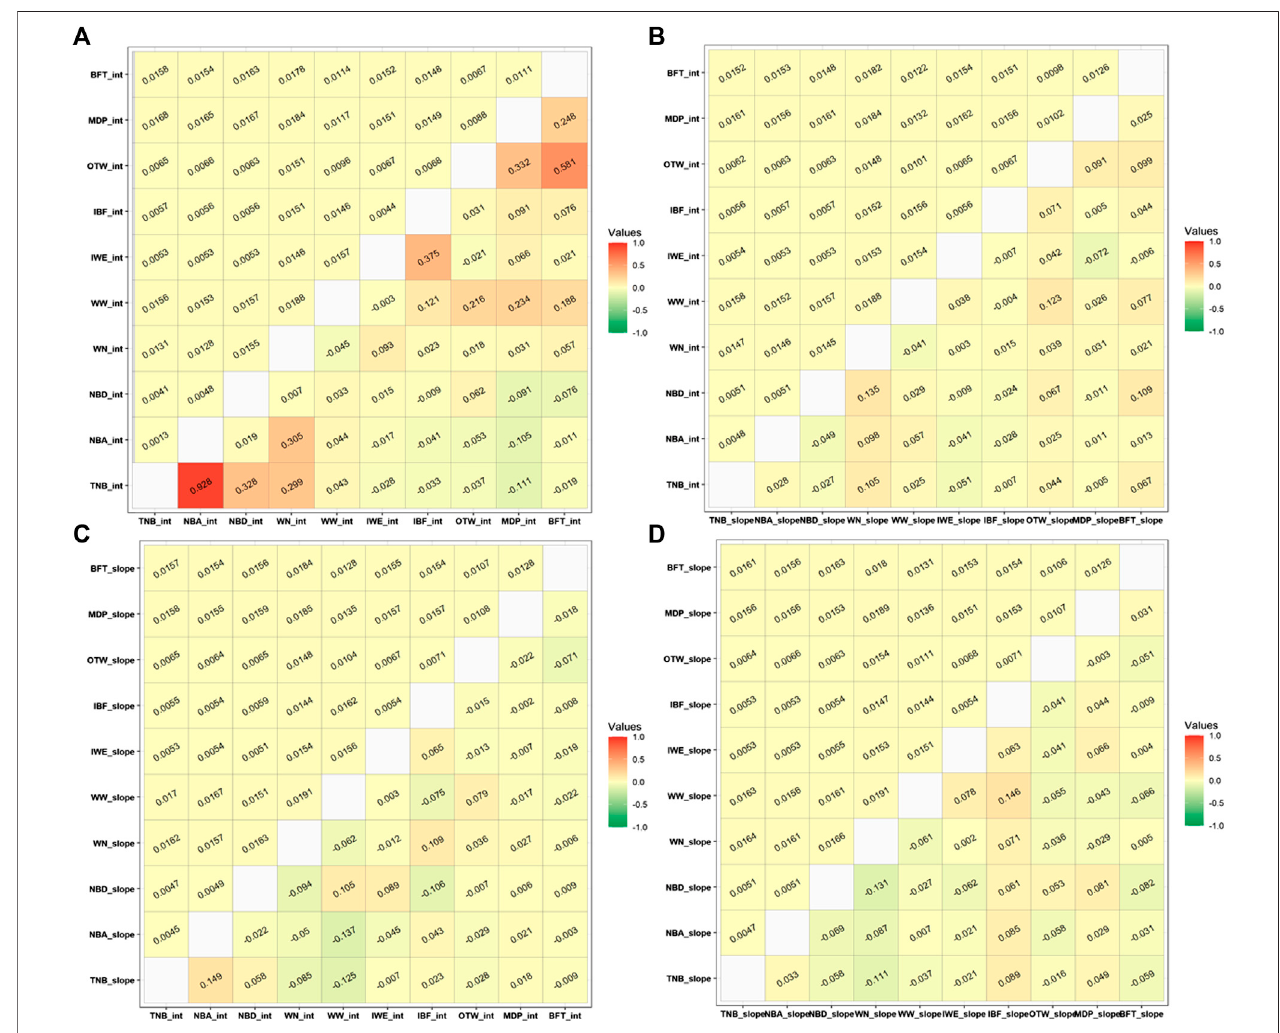
FIGURE 4 | Approximated Pearson genetic correlations (lower) and standard errors (upper) among (A) intercept terms, (B) intercept and slope, (C) slope and intercept, and (D) slope terms of the recommended environmental variable and critical period for each studied trait. TNB, total number of piglets born; NBA, number of pigletsbornalive;NBD,numberofpigletsborndead;WN,numberofpigletsweaned;WW,weaningweight(kg);IWE,intervalbetweenweantoestrus(days);IBF,interval between farrows (days); OTW, off-test weight (kg); MDP, ultrasound muscle depth (mm); BFT, ultrasound backfat thickness (mm). For OTW, MDP, and BFT, we considered a critical period of an average of 30 days before measurement date. For WN and WW, we considered a critical period from 34 days prior to farrowing up to weaning date. For TNB, NBA, and NBD, we considered a critical period of 20 days prior to breeding to 30 days into gestation. For IBF and IWE, we considered a critical period of 34 days prior to farrowing to weaning date.